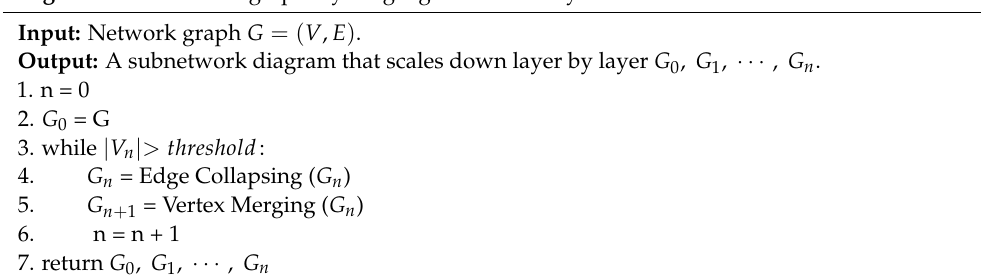
Algorithm 1: Network graph layering algorithm NetLay.